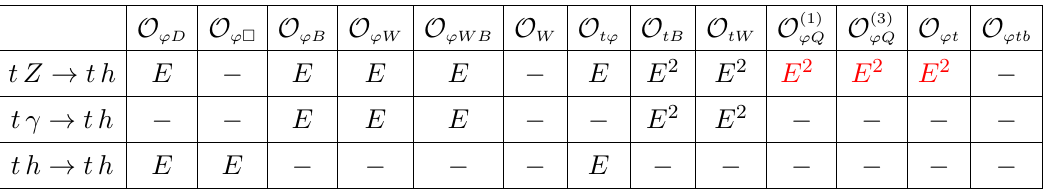
Table 9. Same as table 5 for two top scattering amplitudes with the Higgs. See tables 17{19 for the full helicity amplitude